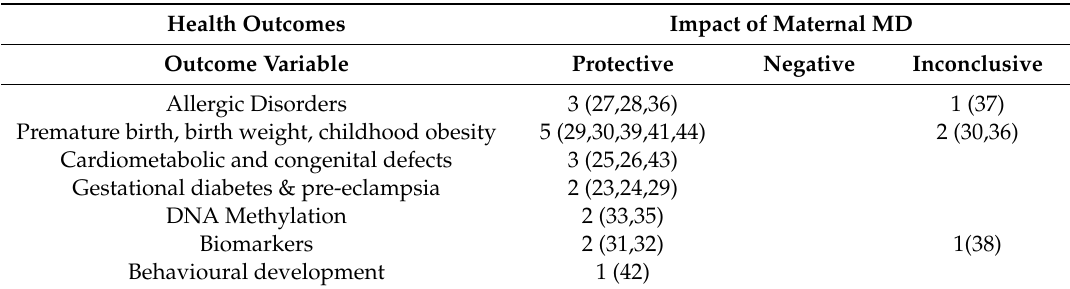
Table 3. A summary of findings from our review of the